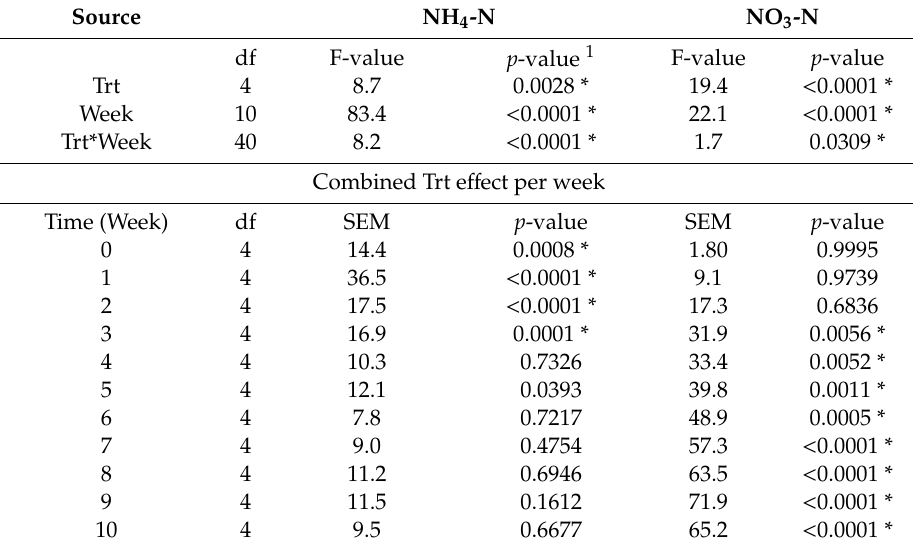
1 * Significant at the 0.05 probability